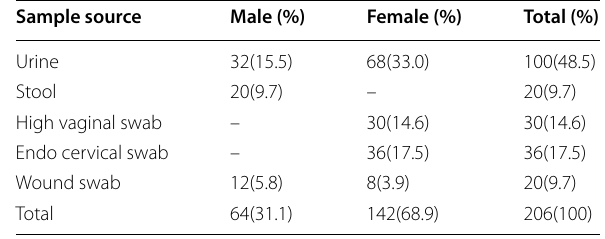
Table 2 The distribution of the E. coli isolates